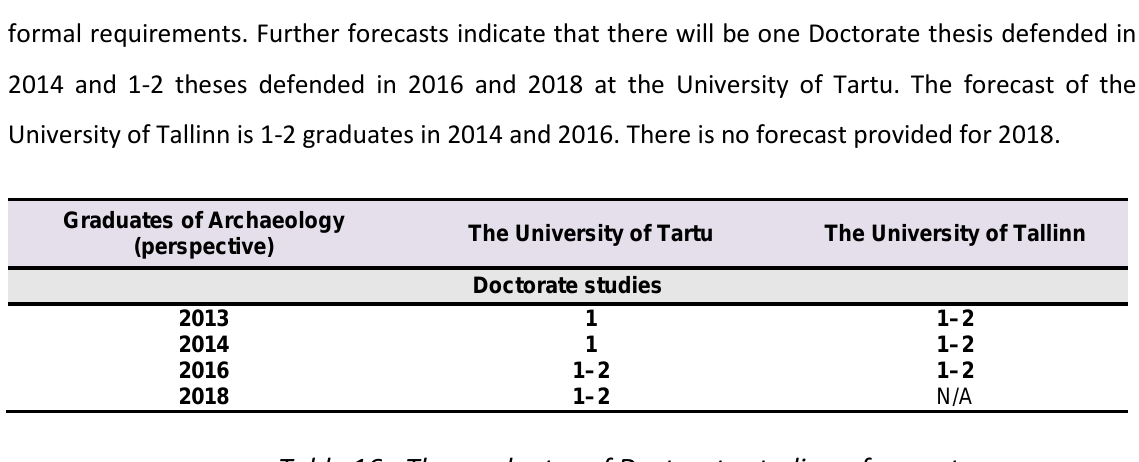
Table 16 - The graduates of Doctorate studies –